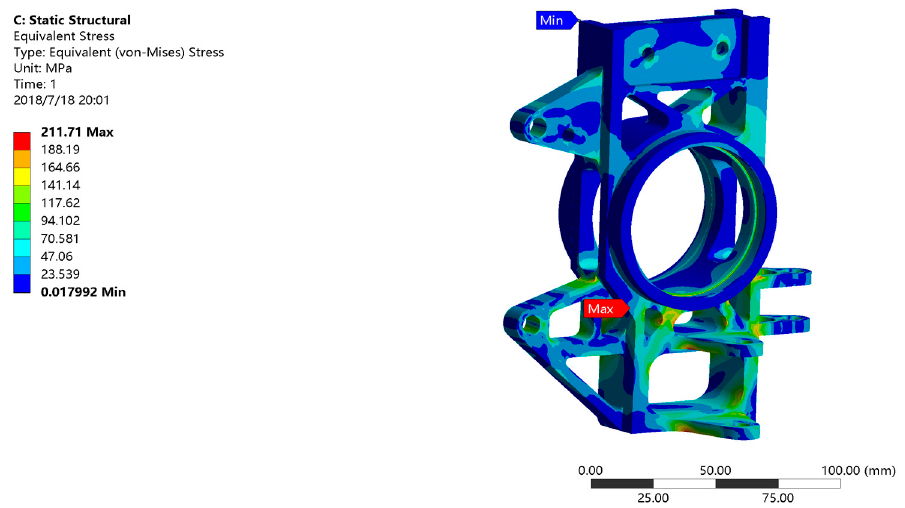
Figure 12. Stress cloud.